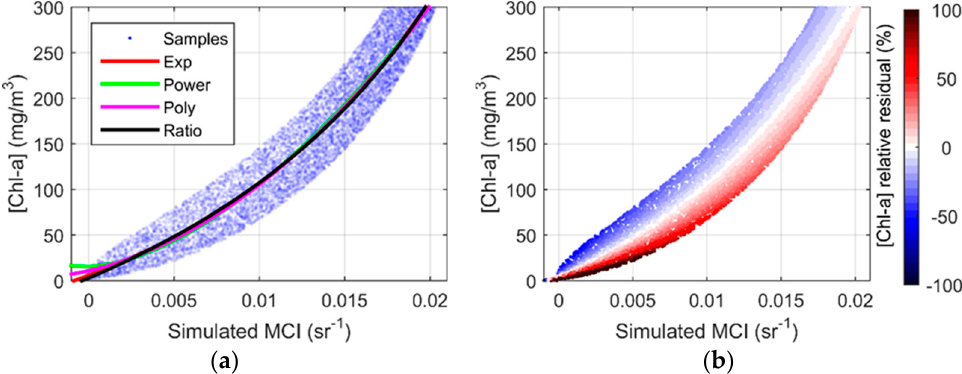
Figure 4. ( a ) Ten thousand simulated MCI based on variable [Chl-a] and [MSPM] with global best-fit relationships, also reported in Table 2. ( b ) Distribution of modelled [Chl-a] residual (MAPE) by applying the exponential fitting in (a). Table 2. Comparison of different theoretical models for the relationship between [Chl-a] and MCI. Note that MCI was multiplied by 10 3 for the coefficients below.